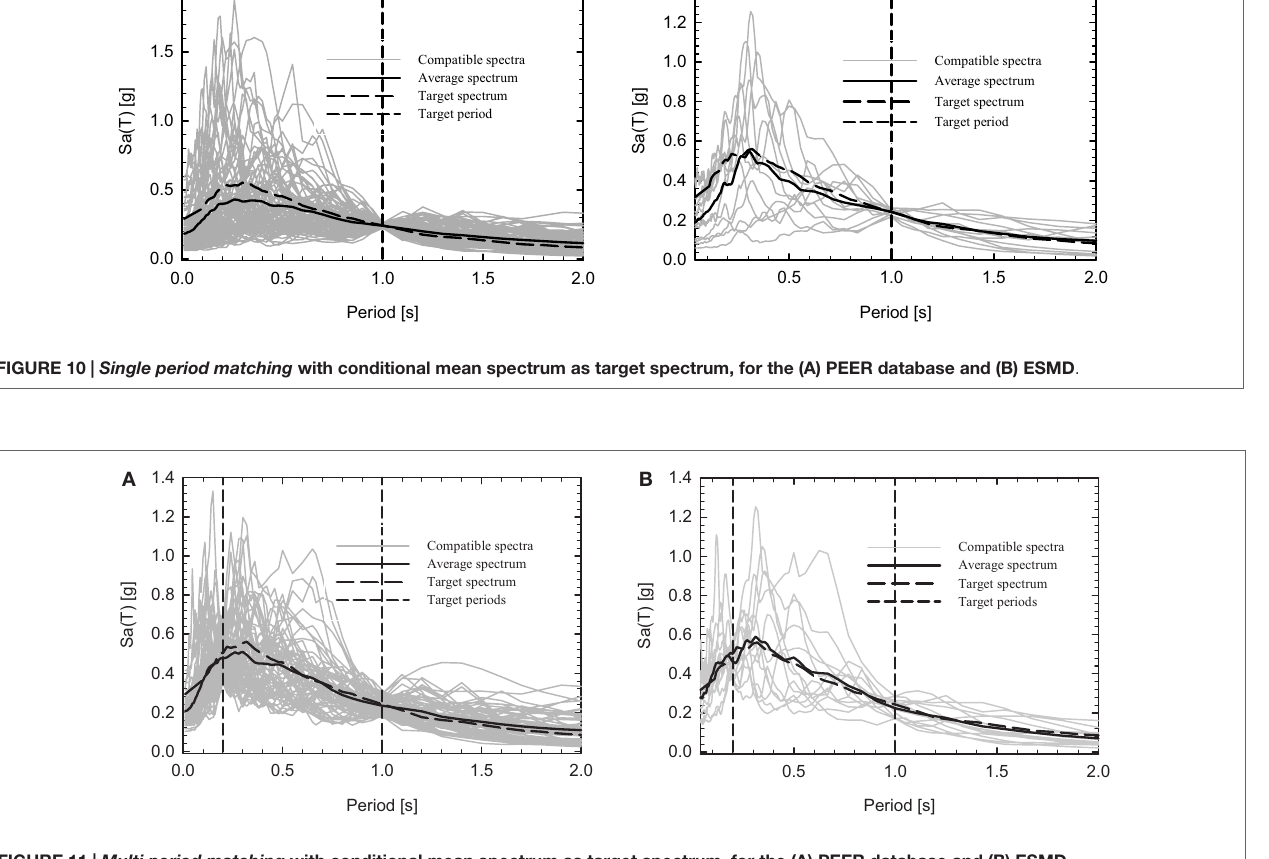
FigUre 11 | Multi period matching with conditional mean spectrum as target spectrum, for the (a) Peer database and (B) esMD